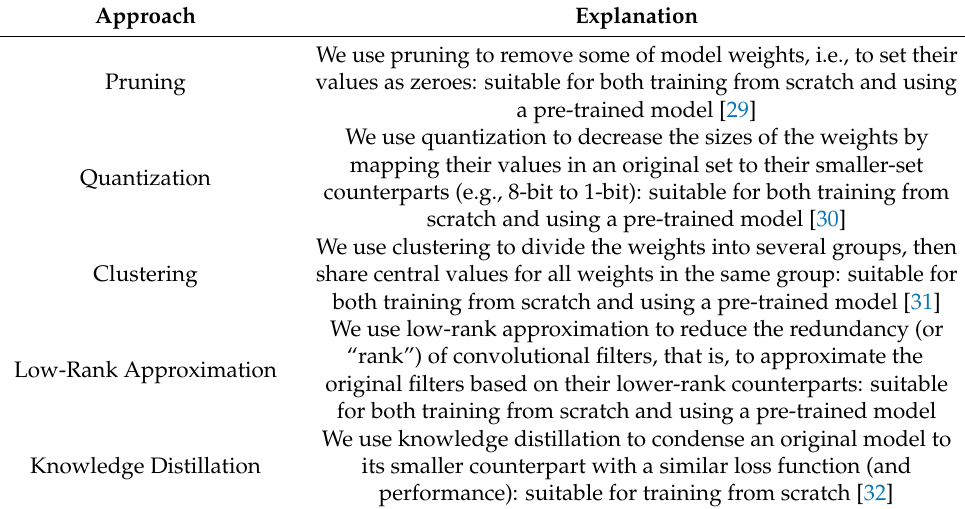
Table 2. Model Compression for Deep Learning.